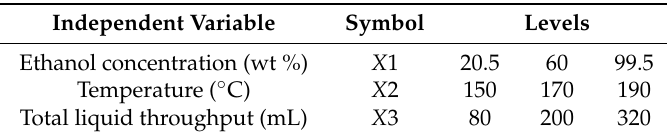
Table 1. RSM design conditions for organosolv